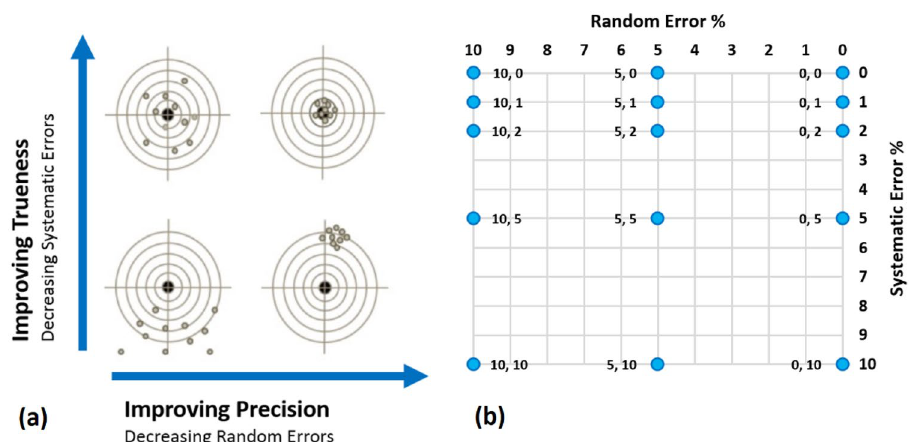
Fig. 3 a Different states of a data set in terms of its trueness and precision and; b the error values of the data sets employed in this research (each blue point represents both systematic and random error values for one of the data sets). The defined data sets in b represent different states in a